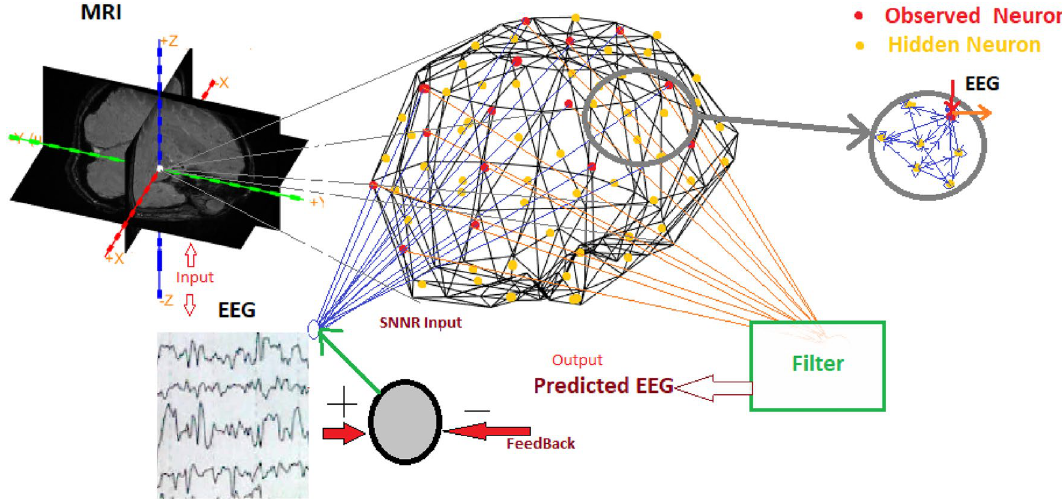
Figure 1. A schematic diagram of the proposed MRI-SNNr architecture for EEG signal modelling and prediction using personalized MRI data for structuring the SNNr (“hidden” neurons, in yellow,) and EEG input data for training the SNNr (input/output neurons, also called observed neurons, in red).